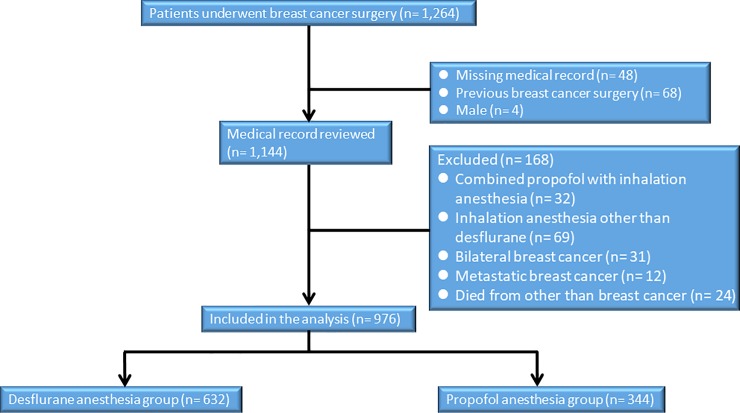
Flow diagram of the study population.